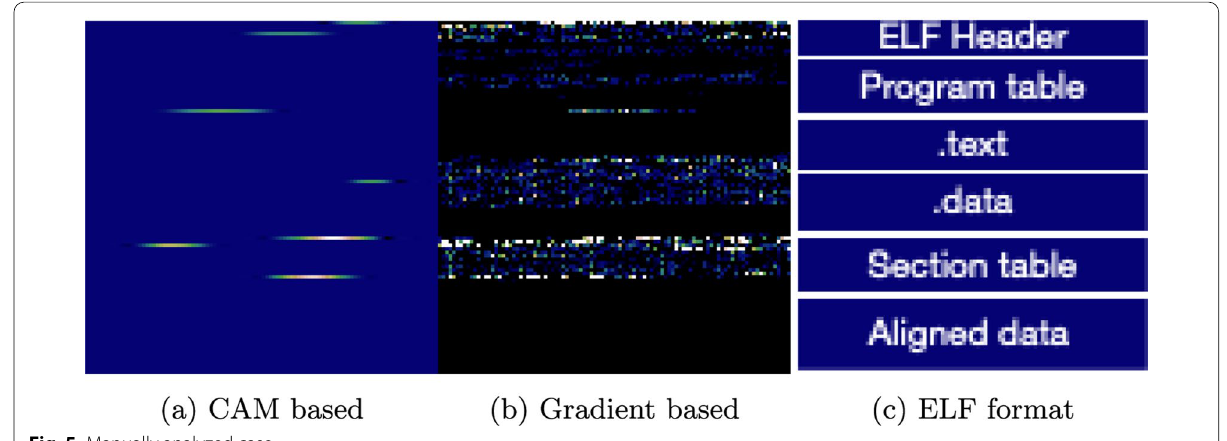
Fig. 5 Manually analyzed